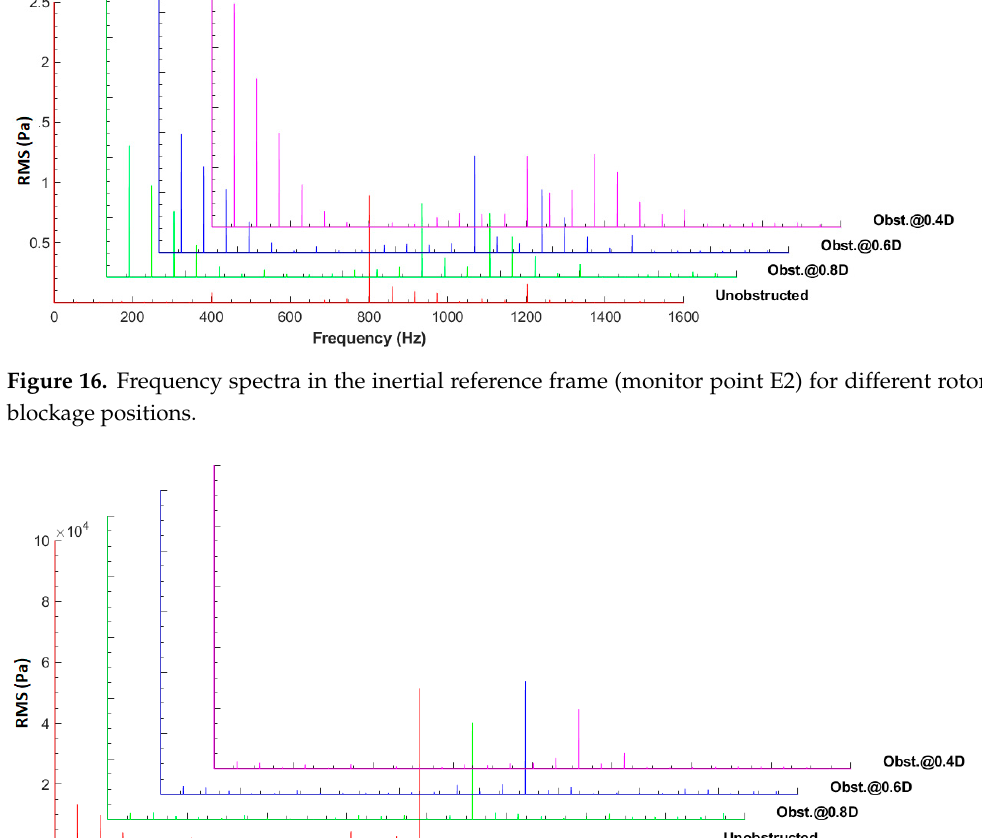
Figure 17. Frequency spectra in the rotating reference frame (monitor point R3) for different rotor blockage positions.